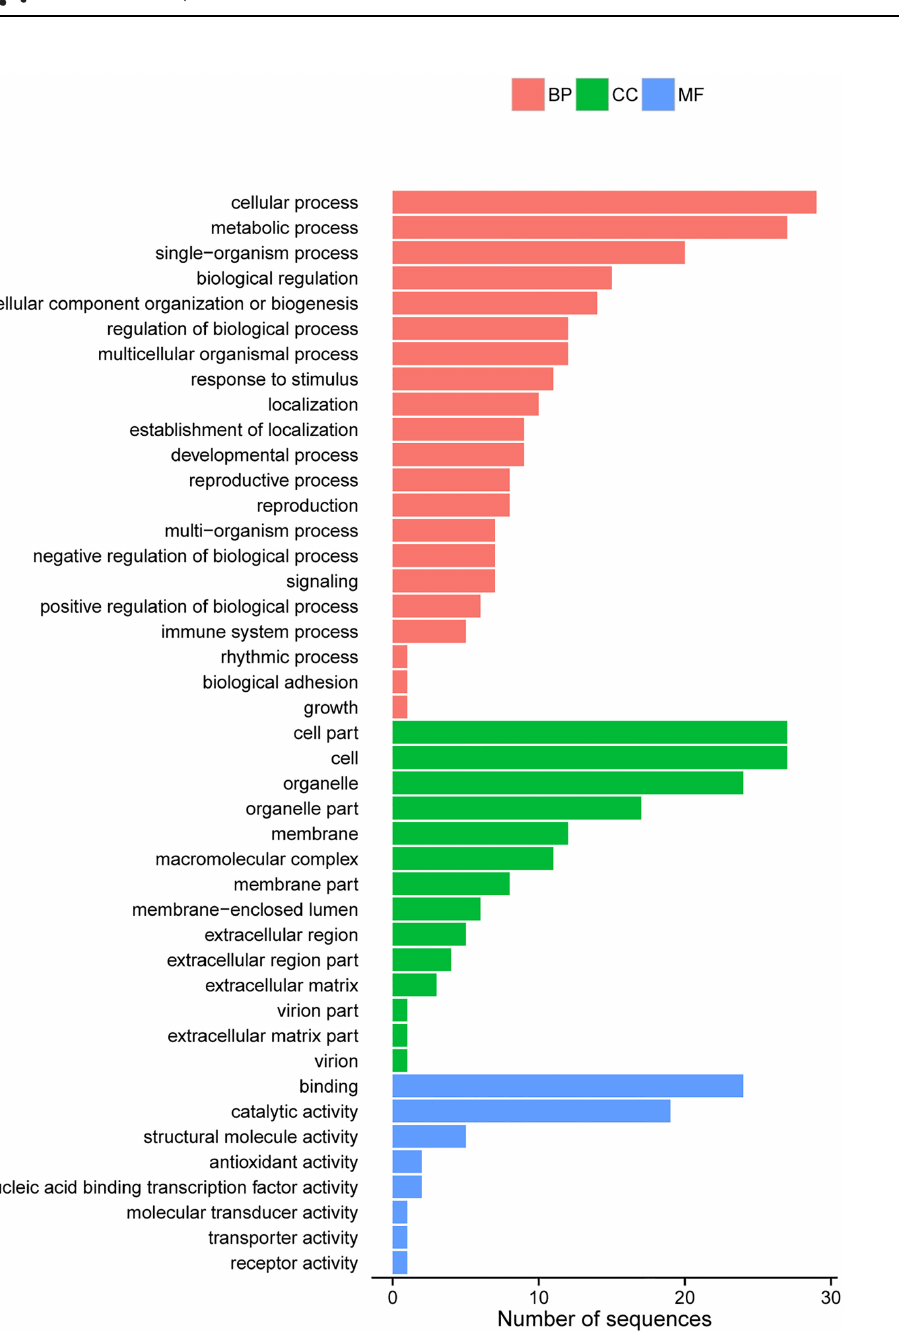
Fig 4. Histogram presentation of diff-Gene Ontology classification. The results are summarized in three main categories: biological process, cellular component and molecular function. The y-axis on the right indicates the number of genes in a category. The y-axis on the left indicates the percentage of a specific category of genes in that main